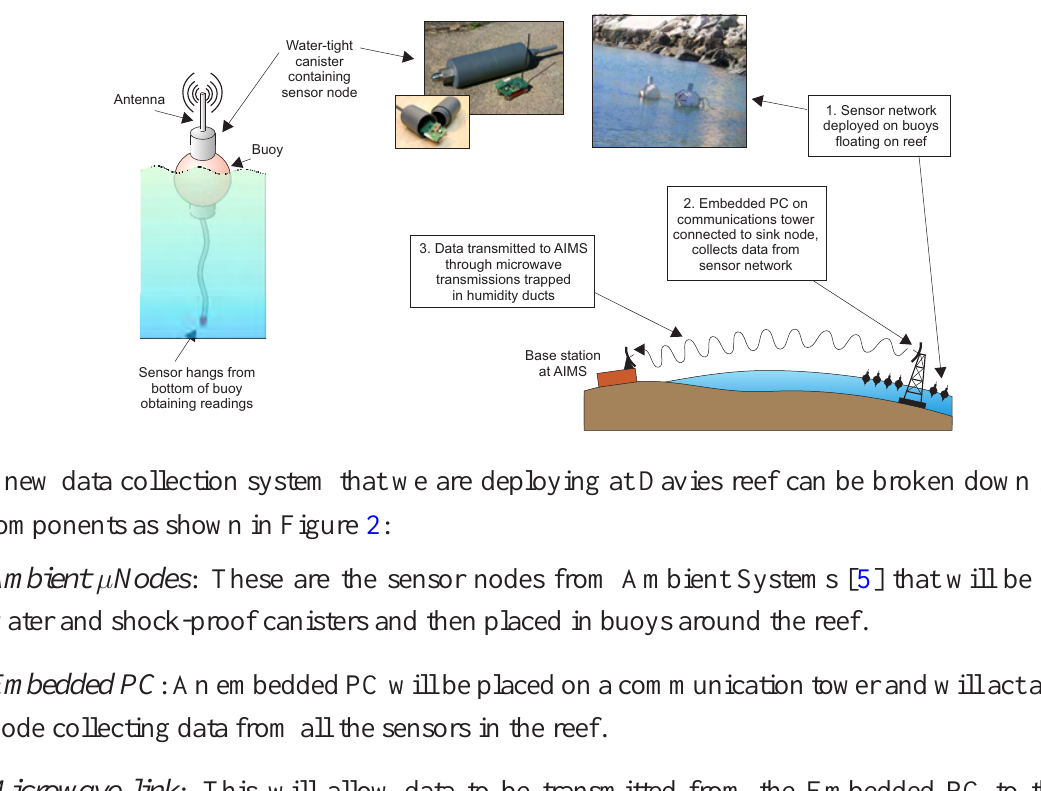
Figure 2. Overview of data collection system at Davies Reef.